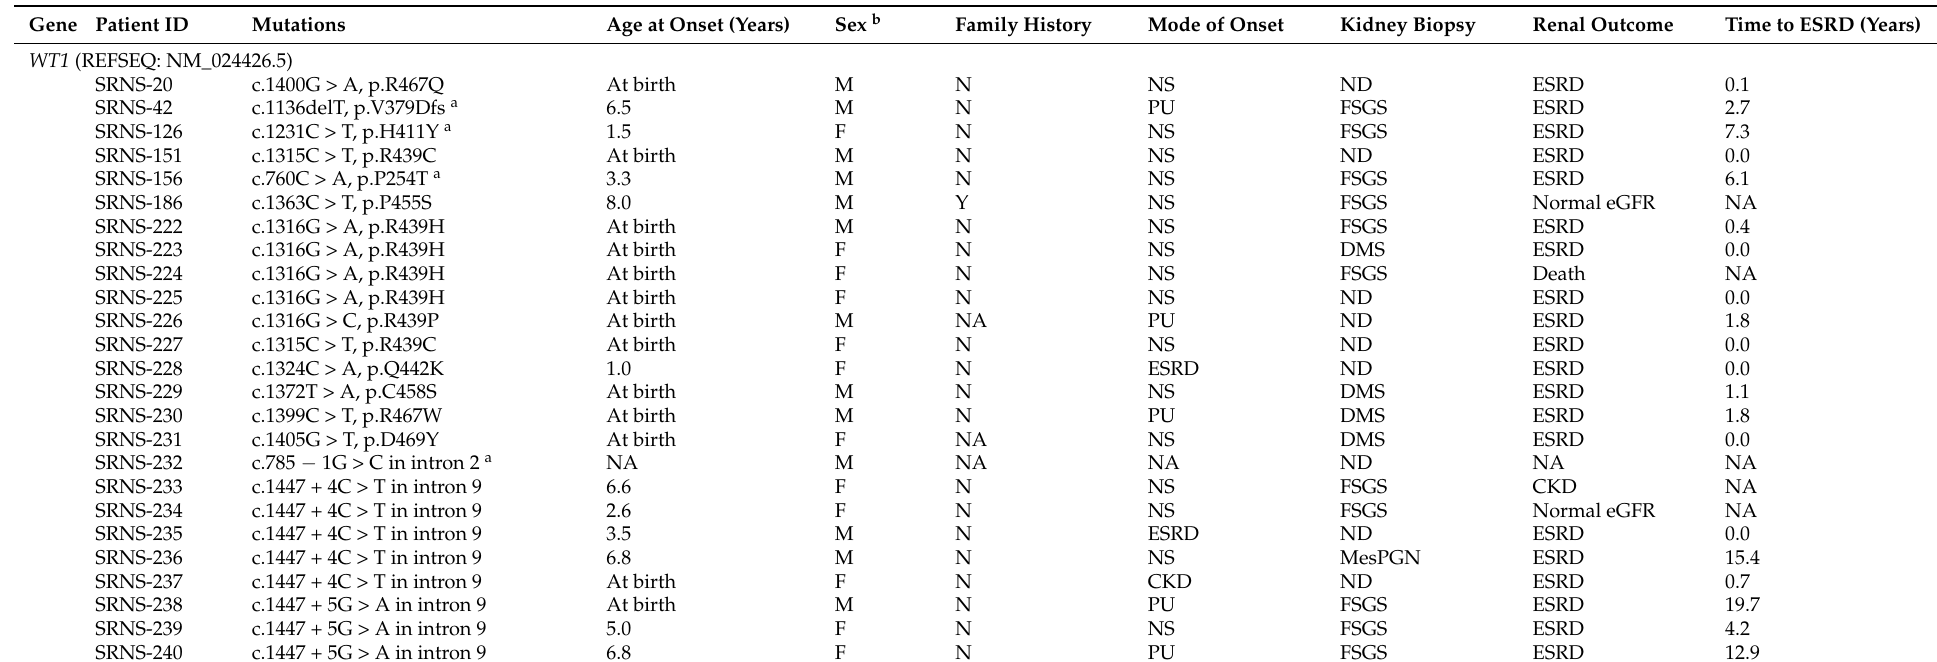
Table S2. Genotypes and phenotypes of patients with disease-causing